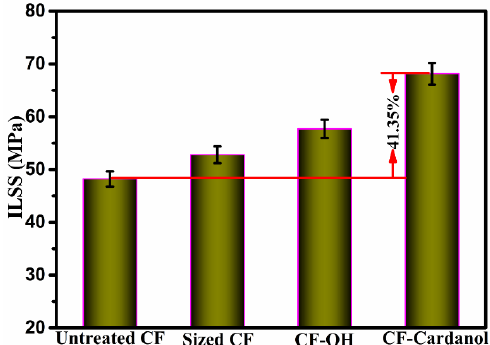
Figure 5. ILSS results of untreated and modified composites.